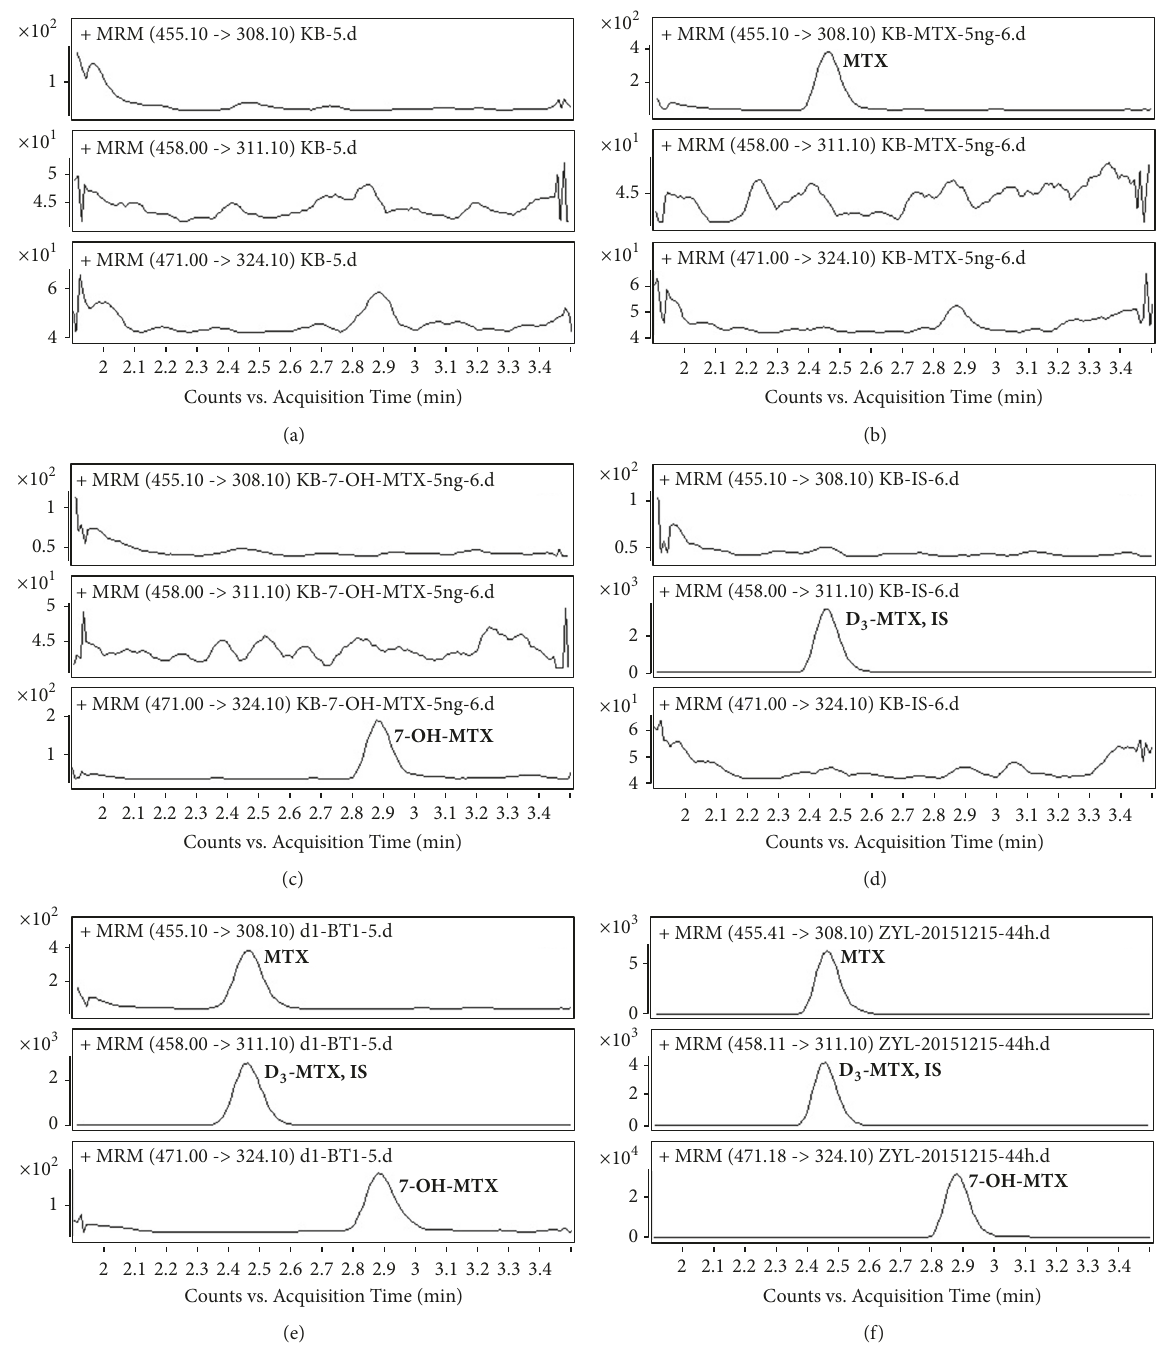
Figure 3: The chromatograms of MTX, 7-OH-MTX, and IS under MRM mode: (a) blank sample; (b) blank plasma spiked with MTX (5ng/mL); (c) blank plasma spiked with 7-OH-MTX (5ng/mL); (d) blank plasma spiked with IS; (e) lower limit of quantification sample; (f) real sample collected at 44h after the administration of MTX from one